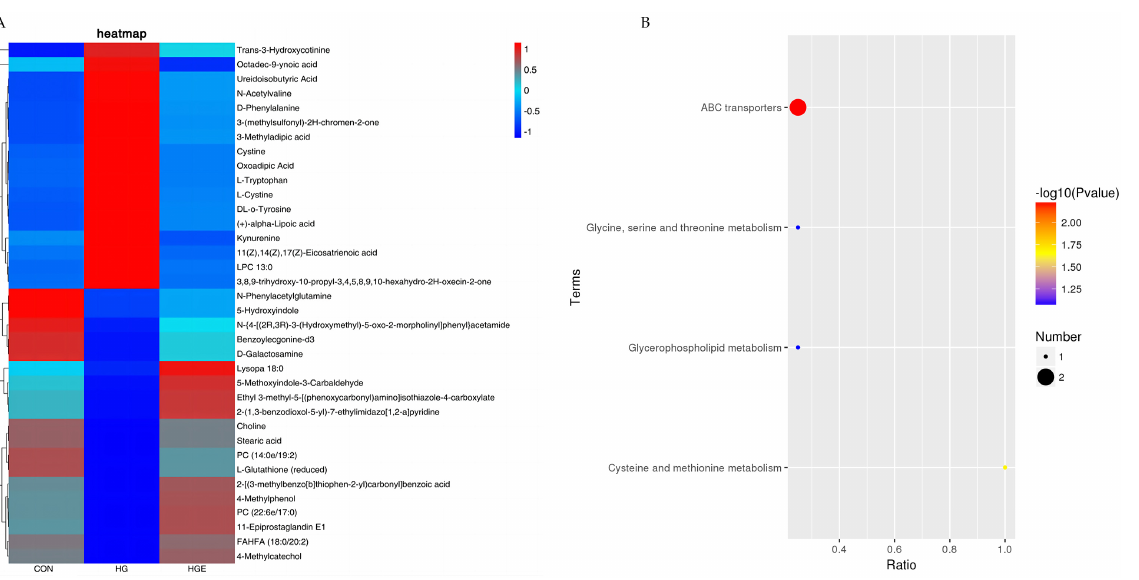
Figure 2. Functional annotation of differential metabolites. ( left ) CON-HG, ( right ) HG-HGE.